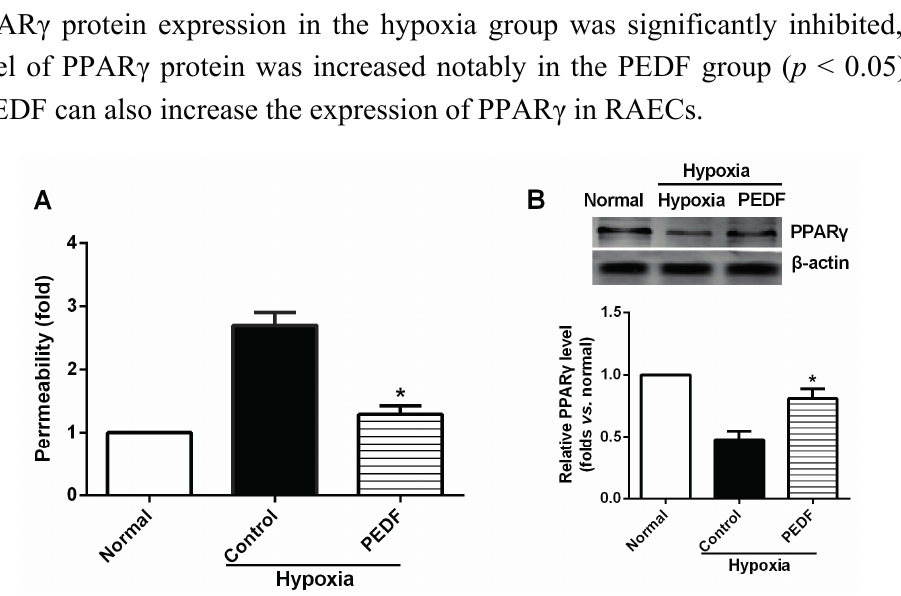
Figure 5. PEDF prevents permeability and increases the expression of PPAR γ under hypoxia in rat aortic endothelial cells (RAECs). Endothelial permeability ( A ) was determined. PEDF significantly reduced hypoxia-induced RAECs permeability ( n = 6); and ( B ) PEDF increased the expression of PPAR γ under hypoxia in RAECs ( n = 3). Data shown in ( A ) and ( B ) are presented as mean ± SD. * p < 0.05 vs. the control